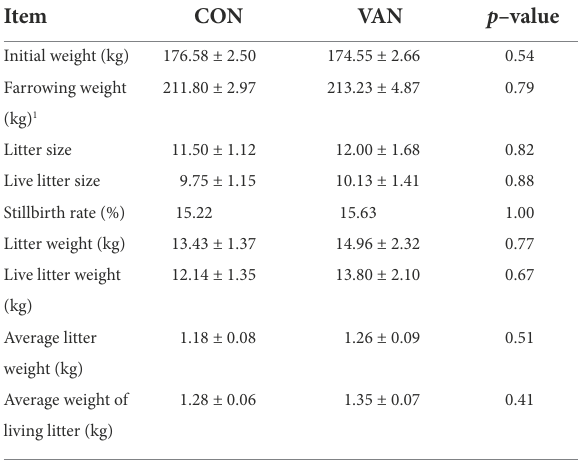
TABLE 1 Effects of vancomycin supplementation on reproductive performance of sows.